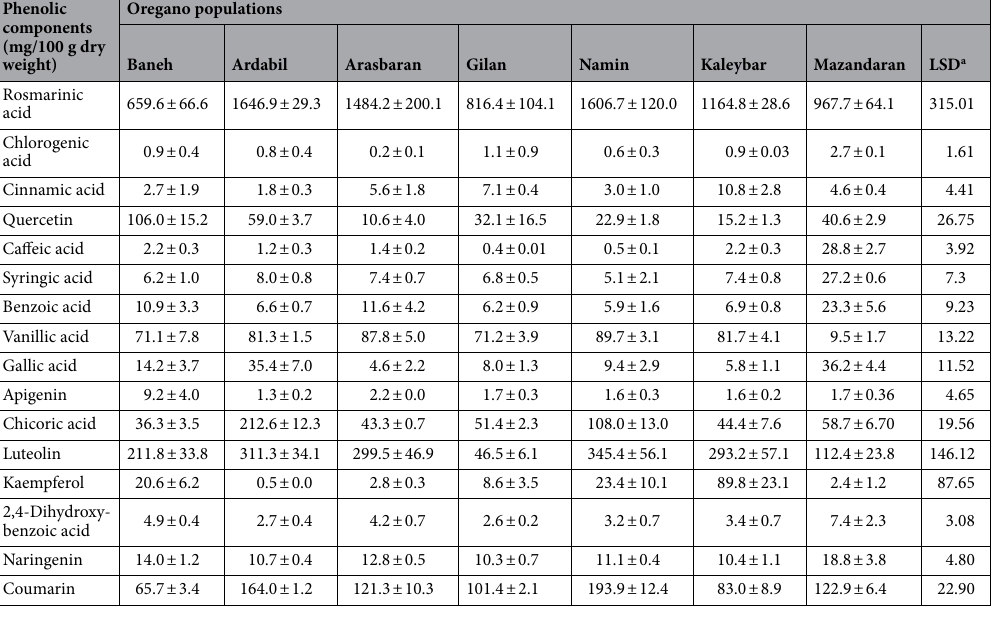
Table 2. Phenolic components in extract of seven oregano accession ± standard deviation (SD). a Within each row means with the least significant difference (LSD test at 0.05 level) are not significantly different from each